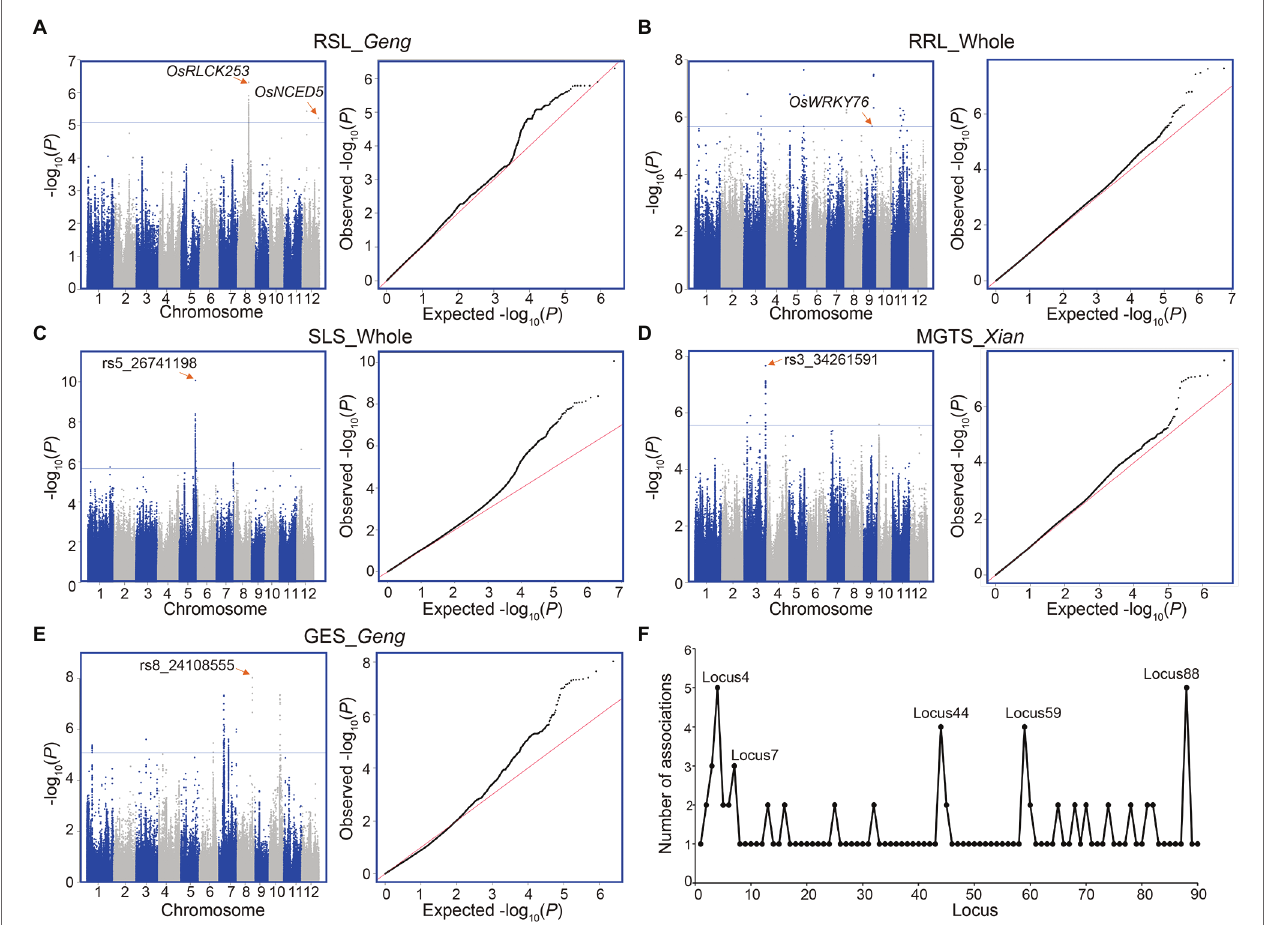
FIGURE 2 | Genome-wide association study of five alkali tolerance-related traits. (A) RSL in the Geng subpopulation. (B) RRL in the whole population. (C) SLS in the whole population. (D) MGTS in the Xian subpopulation. (E) GES in the Geng subpopulation. (F) Number of associated traits for each of all detected loci ( Supplementary Table 3 ). Manhattan plot (left) and Q–Q plot (right) for each panel in (A–E) . Horizontal lines indicate in the Manhattan plots indicate the genome- wide suggestive thresholds. The names of candidate genes or lead SNPs are shown above the corresponding association